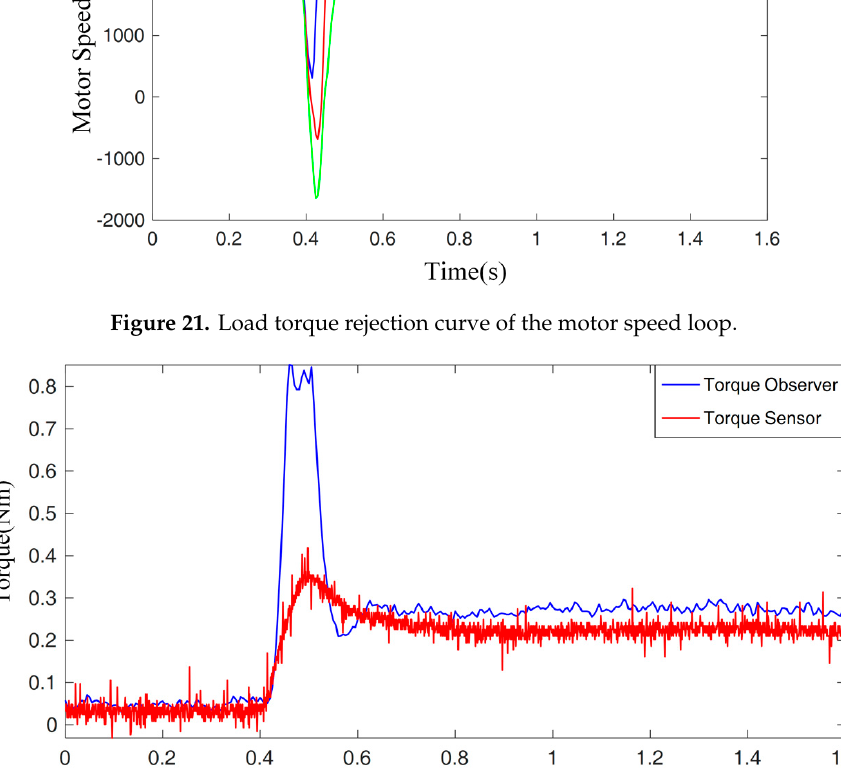
Figure 22. Comparison of the load torque observer and the torque sensor.